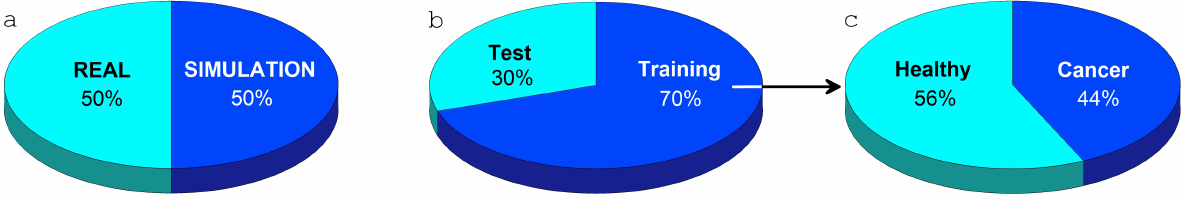
Figure 14. Samples structure used in machine learning algorithms: the sizes of “REAL” and “SIMULATION” datasets ( a ), Test and Training datasets ( b ), “Healthy” and “Cancer” classes ( c